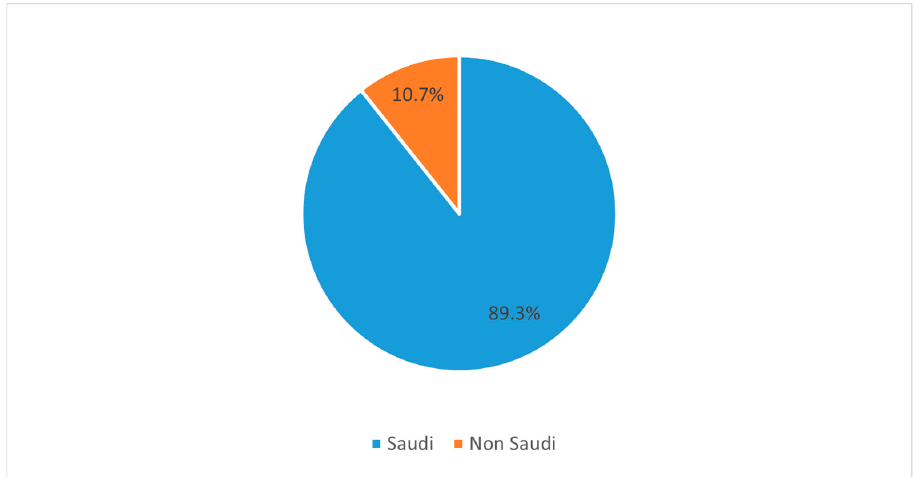
Figure 2. Pie chart illustrates the distribution of participants based on their nationality.